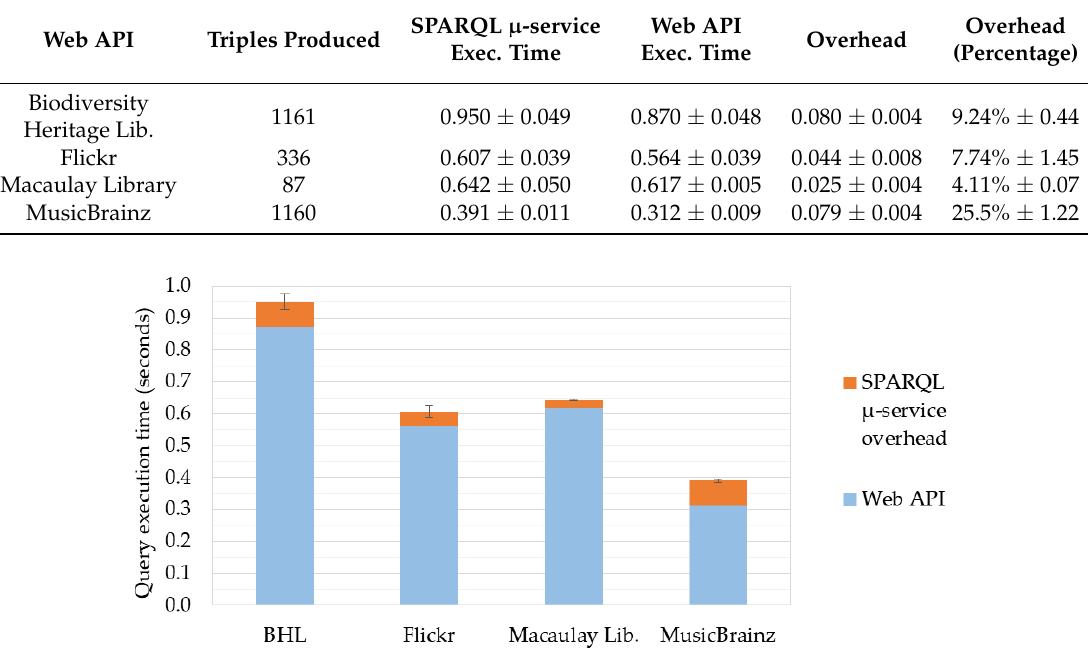
Figure 5. Overhead imposed by a SPARQL micro-service invocation as compared to a direct Web API invocation.